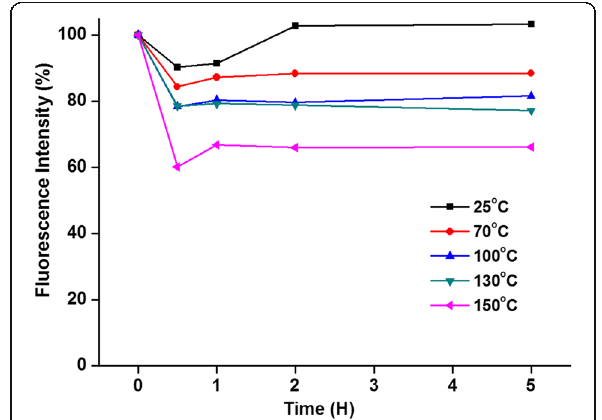
Fig. 4 The changes of fluorescence intensities of InP/ZnS core/shell QDs with different annealing